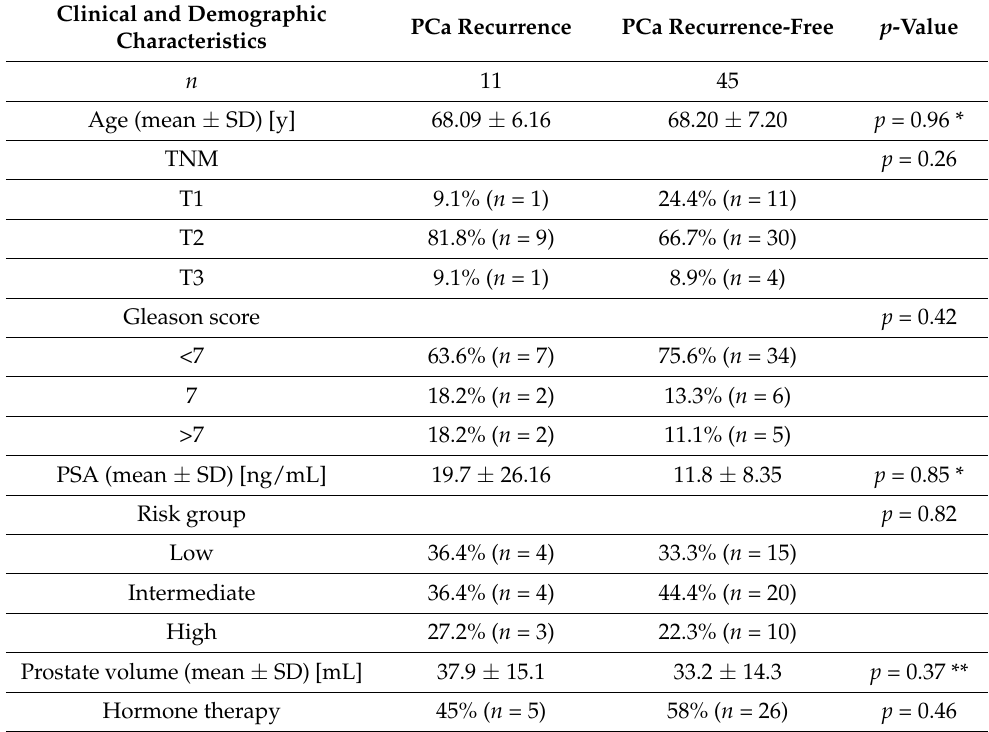
Table 1. Clinical and demographic characteristics of prostate cancer patients.